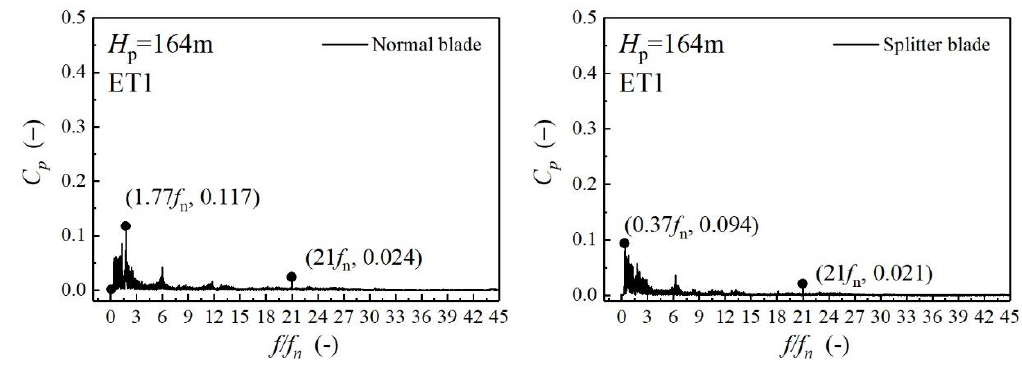
Figure 20. Frequency characteristics in the vaneless space at 164 m head.